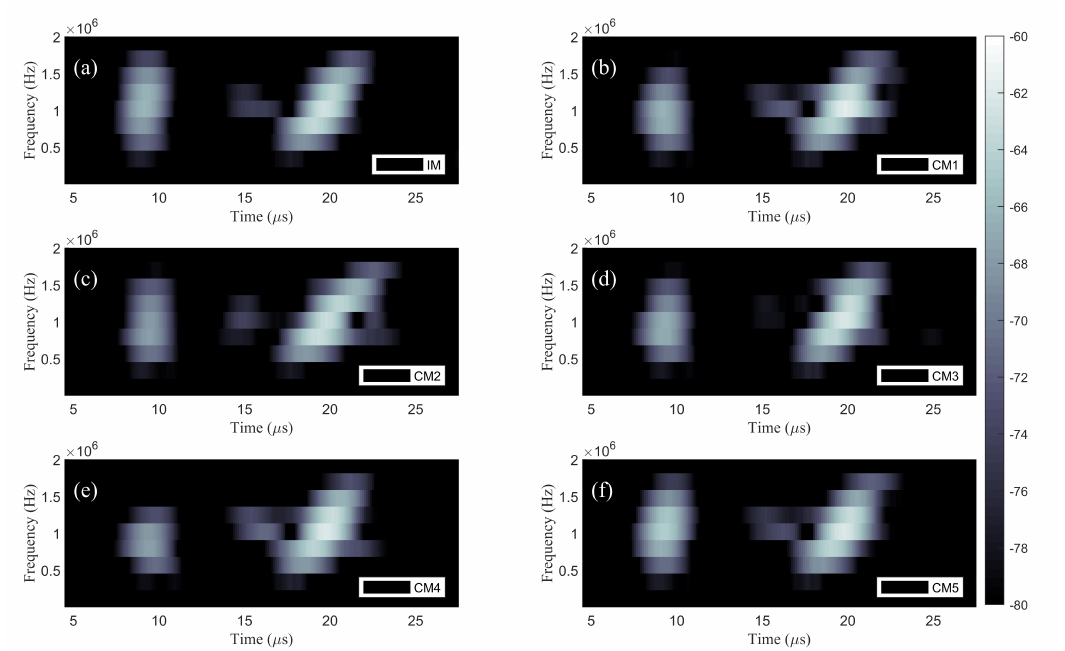
Figure 7. Spectrogram of ( a ) model IM; ( b ) model CM1; ( c ) model CM2; ( d ) model CM3; ( e ) model CM4; and corroded steel rod models at receiver R (f) model